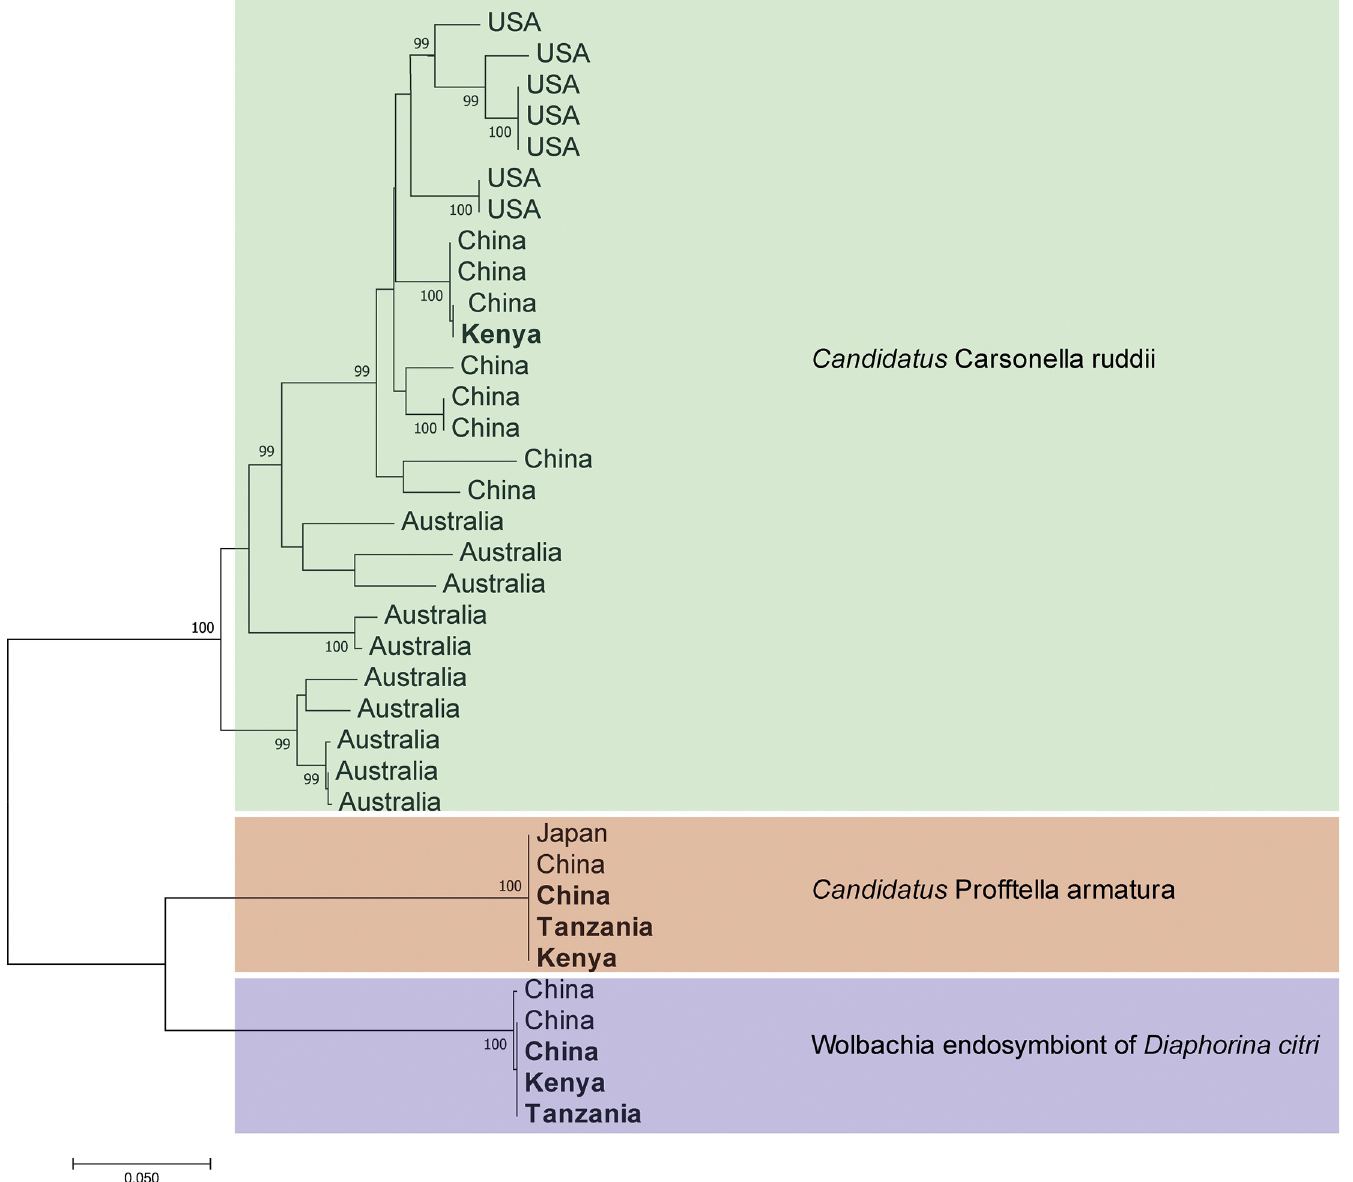
Fig 1. Maximum-likelihood tree based on 16S ribosomal RNA gene sequences of “ Candidatus Carsonella ruddii”, “ Candidatus Profftella armatura” and Wolbachia endosymbiont of Diaphorina citri from China, Kenya and Tanzania and representative sequences from publicly available sequences on GenBank. Branch support was based on 1000 bootstrap replicates. Samples from this study are in bold font.